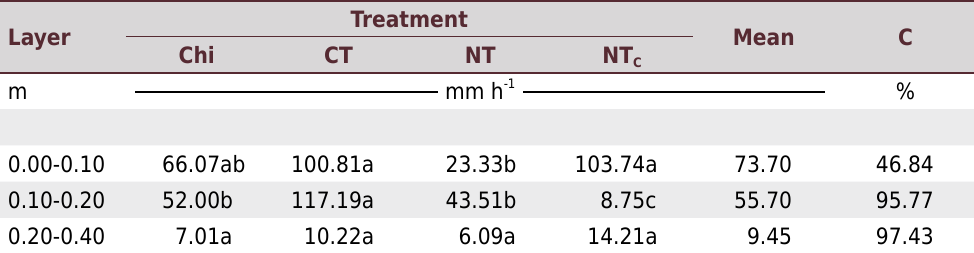
Table 8. Saturated soil hydraulic conductivity (mm h -1 ) in three soil layers and four tillage methods at physiological maturity of the cassava crop